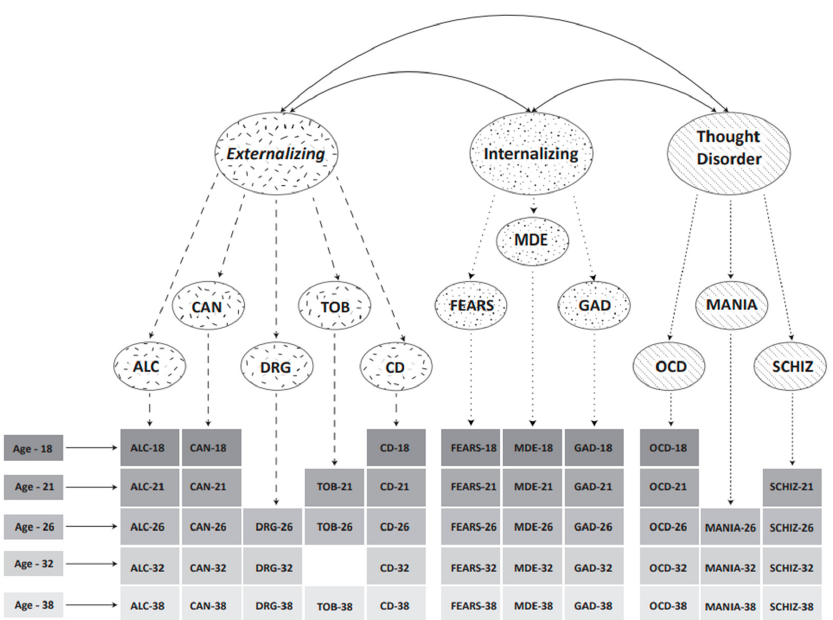
Figure 1. Adapted from Caspi et al. [13]. Ovals represent latent symptom factors; boxes represent the symptoms related to each disorder. The 11 disorders included in the model are: alcohol dependence, cannabis dependence, dependence on hard drugs, tobacco dependence, conduct disorder, major depression, generalized anxiety disorder, fears/phobias, obsessive-compulsive disorder, mania, and positive and negative schizophrenia symptoms. Note . ALC = Alcohol. CAN = Cannabis. DRG = Hard drugs. TOB = Tobacco. CD = Conduct disorder. MDE = Major depressive episode. GAD = General Anxiety Disorder. OCD = Obsessive Compulsive Disorder. SCHIZ = Schizophrenia.